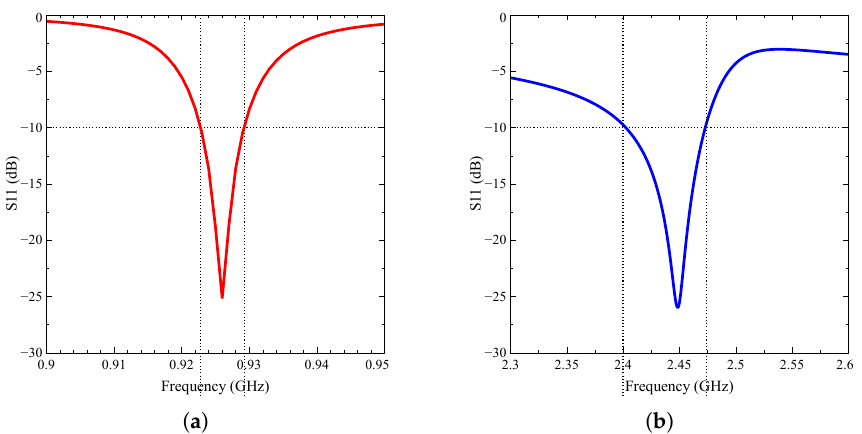
Figure 5. Simulated reflection coefficient of the antenna at ( a ) low-frequency band and ( b ) high-frequency band.